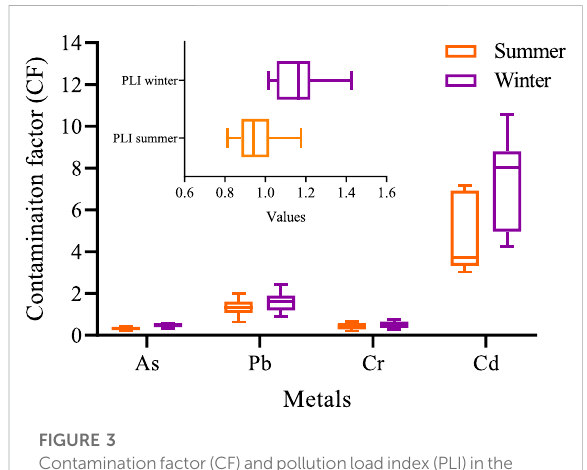
FIGURE 3 Contaminationfactor(CF)andpollutionloadindex(PLI)inthe sediment of the Rupsha